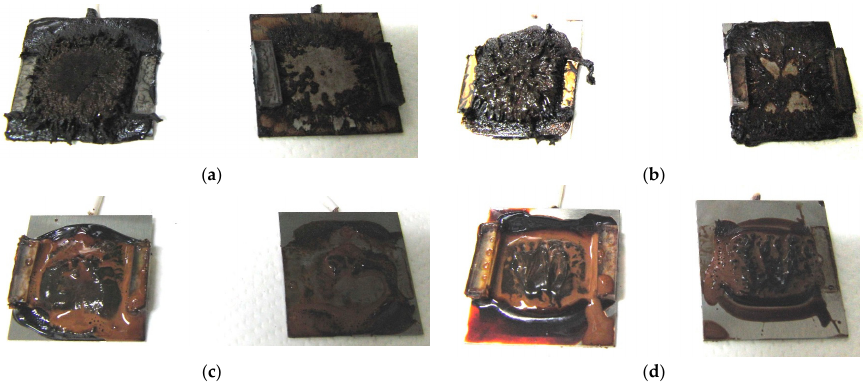
Figure 1. Photographs of Type 2 vulcanized MCF rubber after electrolytic polymerization by four different magnetic field strengths; the left column shows the anode surface, and the right column the cathode surface at: ( a ) 188 mT, Solidification 1; ( b ) 312 mT, Solidification 2; ( c ) 490 mT, Solidification 3; and ( d ) 721 mT, Solidification 4. Table 2. Photographs of spikes in Type 1–5 MCF rubbers before electrolytic polymerization by application of four different magnetic field strengths.